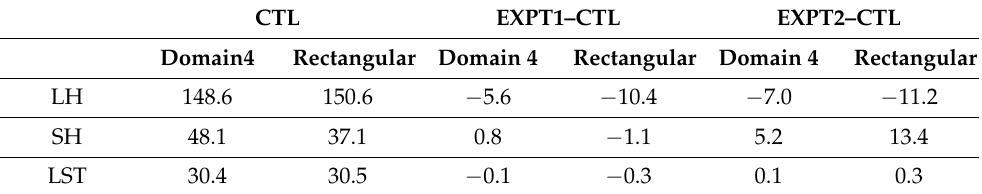
Figure 3. The daily domain-averaged observed (black lines) and CTL (blue lines): ( a ) 2 m air temperature ( ◦ C) and ( b ) precipitation (mm) from 1 to 31 July. The domain calculated is in Figure 2b. Table 1. The averaged latent heat flux (W m − 2 ), the sensible heat flux (W m − 2 ), and the land surface temperature ( ◦ C) in Poyang Lake. The calculation domains are domain 4 and the rectangular dashed box in Figure